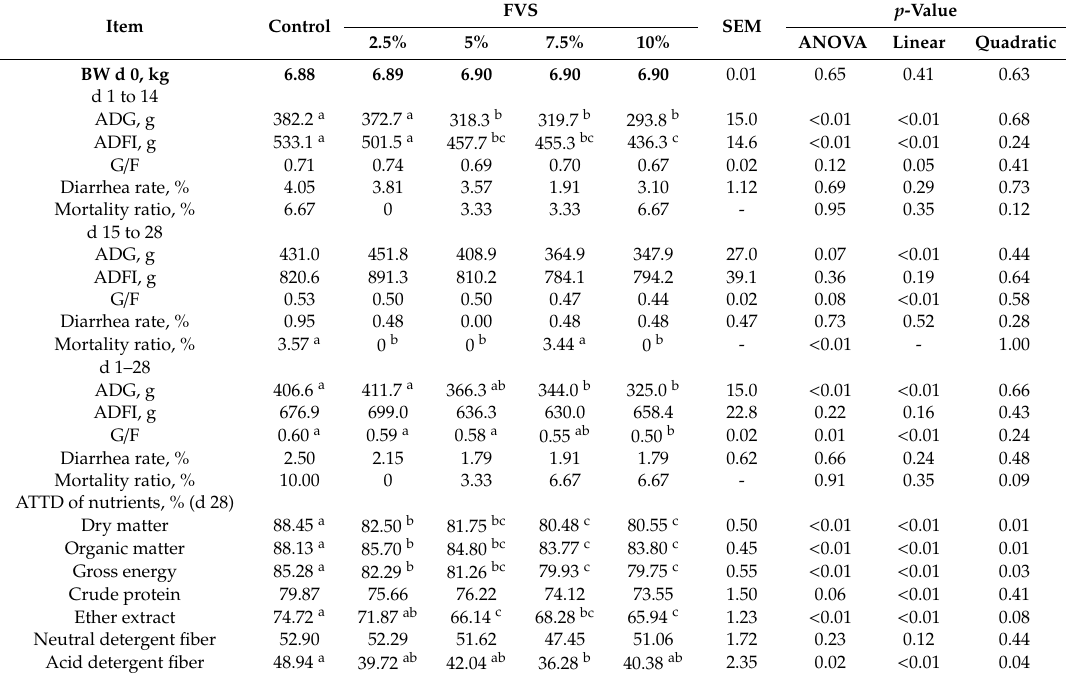
Table 4. E ff ects of Flammulina velutipes stem waste (FVS) supplementation in diets fed to weaned piglets on growth performance and apparent total tract digestibility (ATTD) of nutrients during day 1–28 (Exp.1).